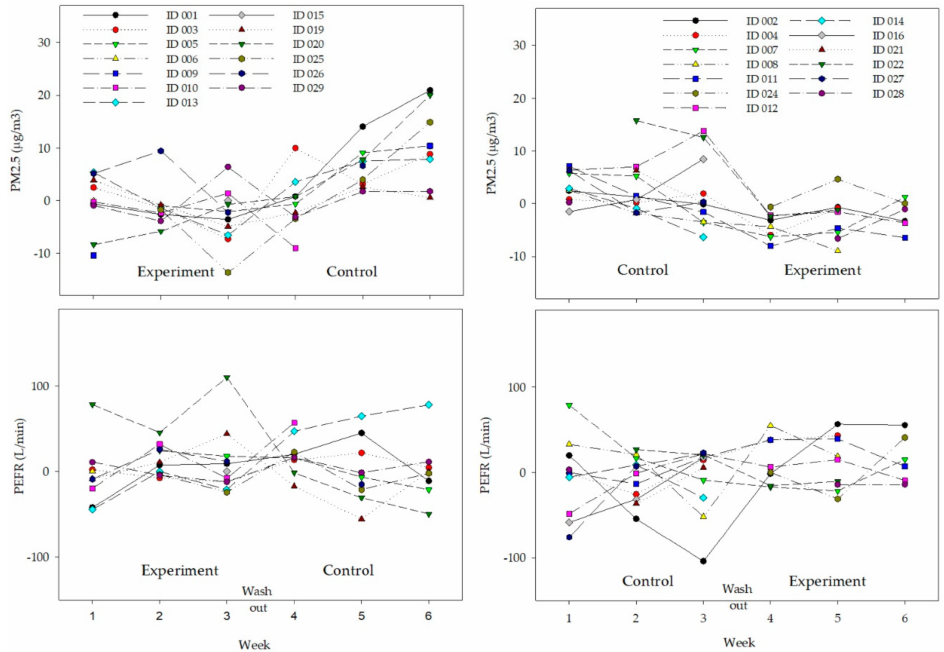
Figure 3. The distribution of person-specific weekly di ff erence of PEFR or PM2.5 values from their median value, obtained over the study period, by intervention